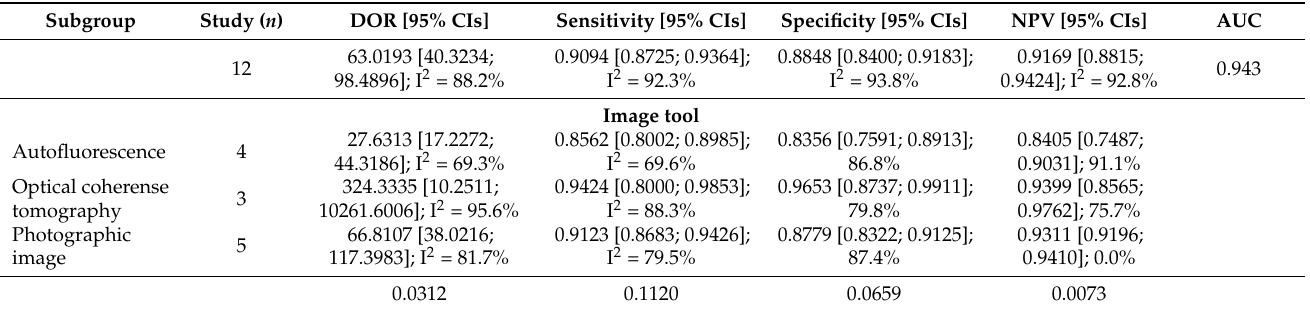
Table 3. Subgroup analysis regarding image tool in discriminating oral precancerous and cancerous lesions from normal